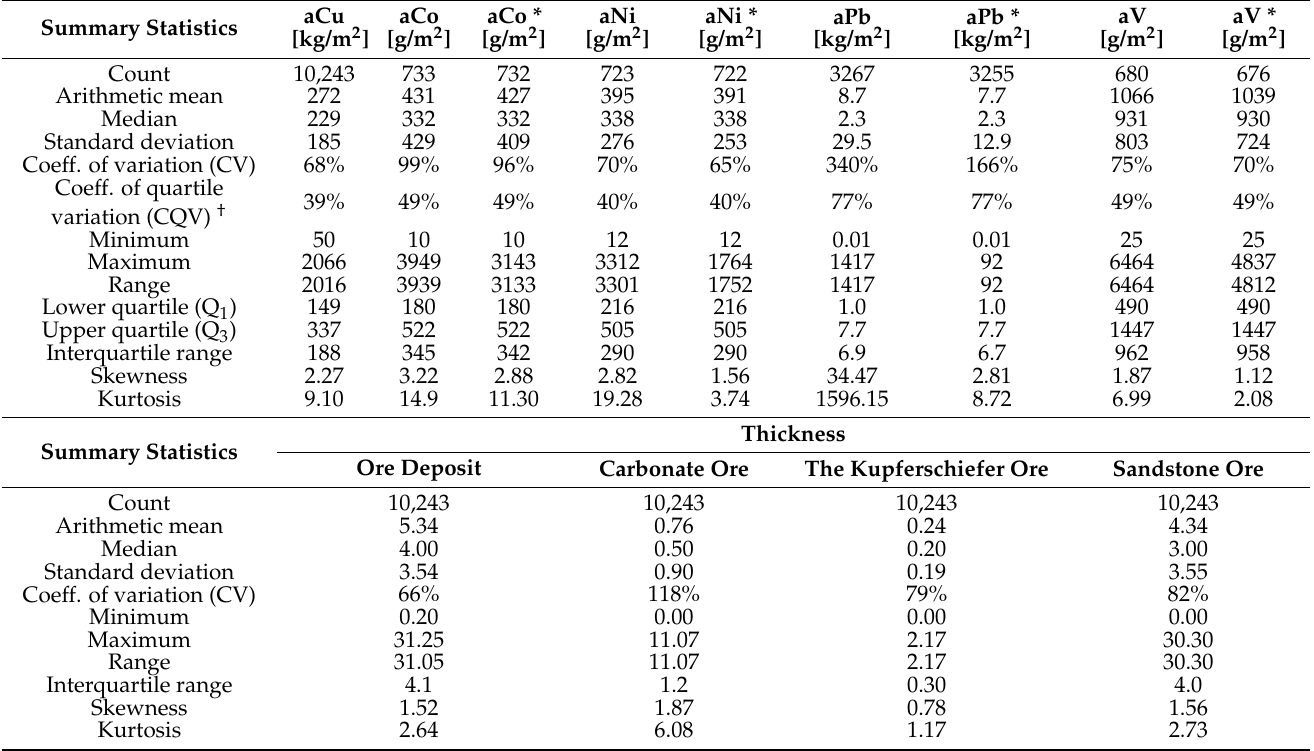
Table 3. Statistics for thickness and Cu abundance (aCu) and abundance of accompanying elements (aCo, aNi, aPb, and aV) in the Cu-Ag Rudna